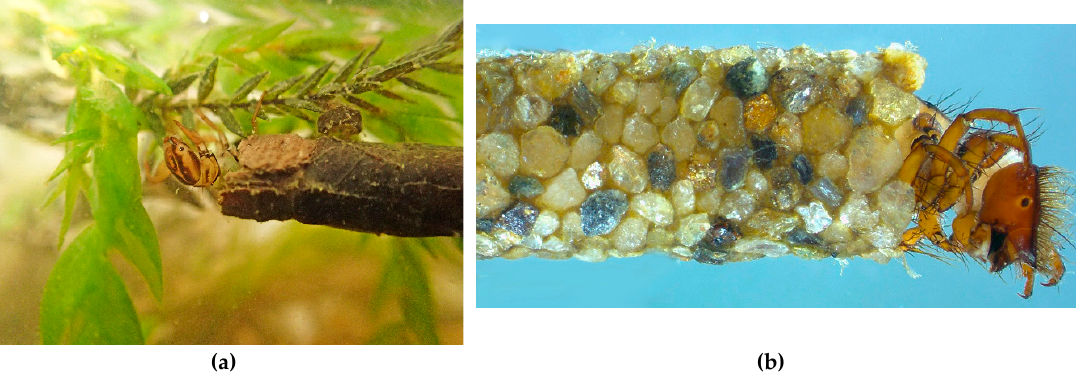
Figure 10. ( a ): Larva of Oligostomis reticulata (Linnaeus, 1761) (Plenitentoria: Phryganeidae) in its case composed of pieces of angiosperm leaves; © W. Graf. ( b ): Larva of Drusus sp. (Plenitentoria: Limnephilidae) in its case composed of gravel; © S. Vitecek.